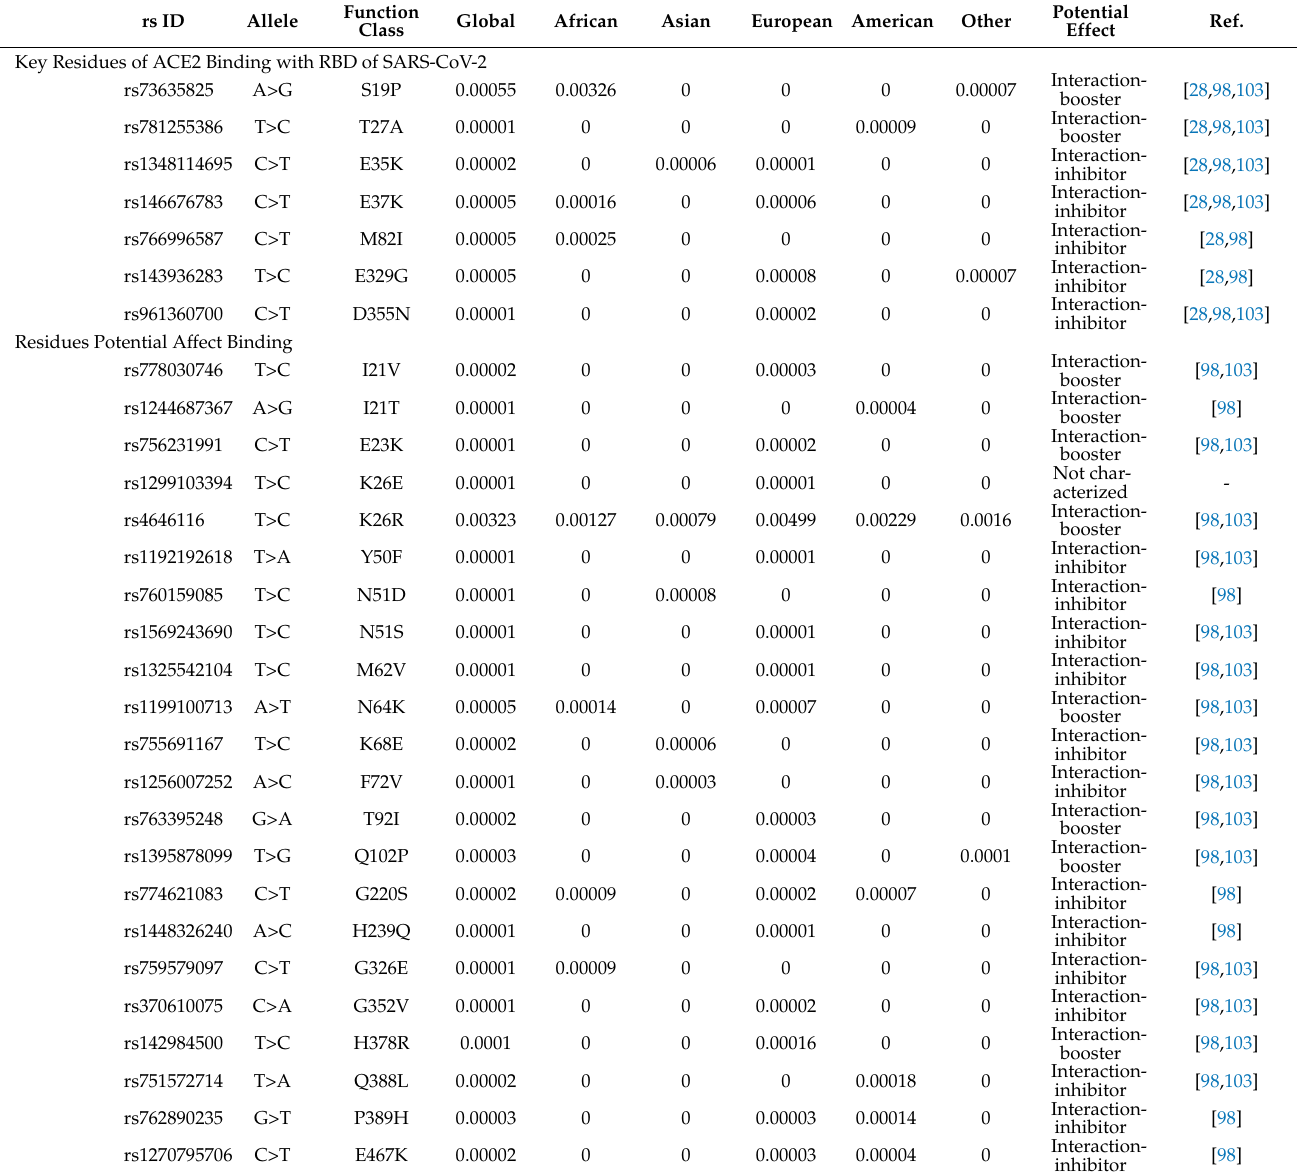
Table 2. Summary of population frequencies of ACE2 genetic variants related to SARS-CoV-2 S glycoprotein interaction. rs